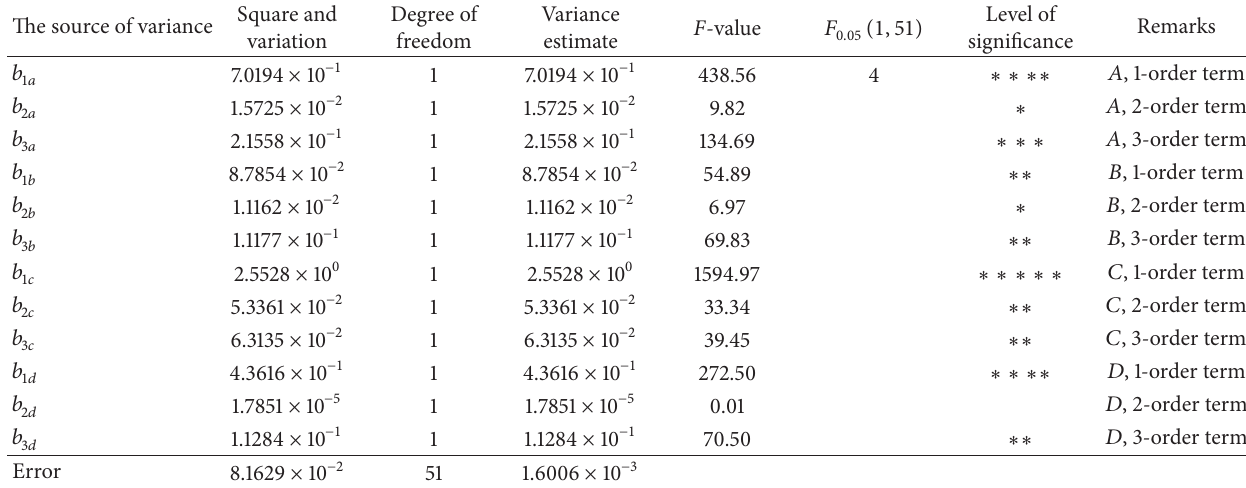
Table 10: Orthogonal polynomial regression analysis of variance: tensile strength index.